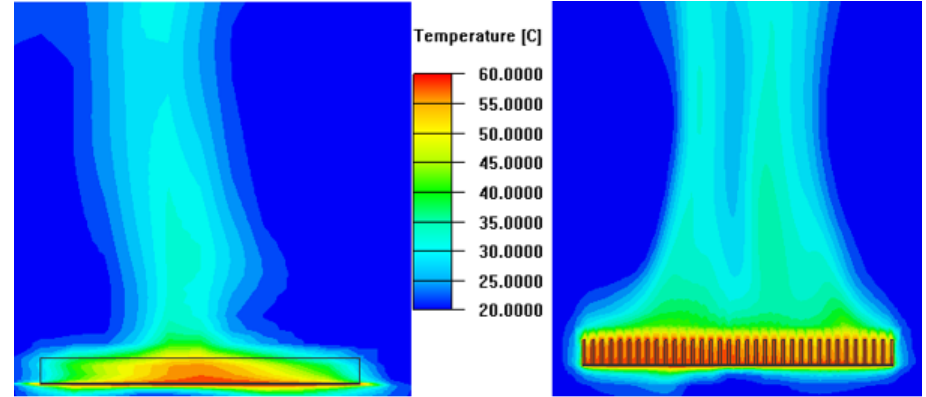
Figure 6. Temperature contours taken at the mid-plane in the longitudinal ( left ) and transverse ( right ) directions without openings in the base ( L = 512 mm, W = 512 mm, t = 2 mm, s = 9.56 mm, and ∆ T = 40 ◦ C).